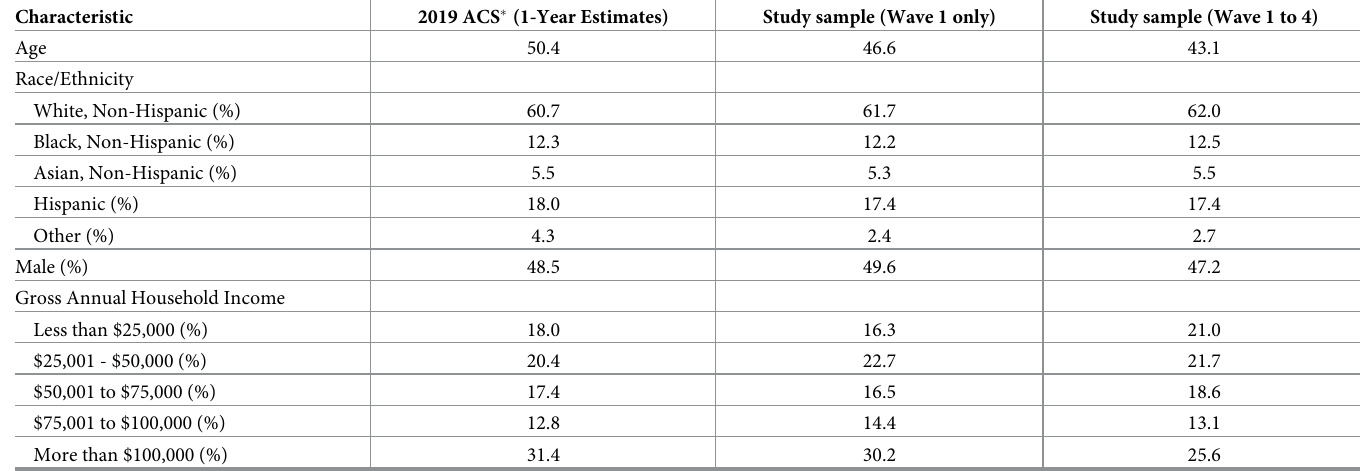
Table 1. Survey sample and ACS 2019 sample